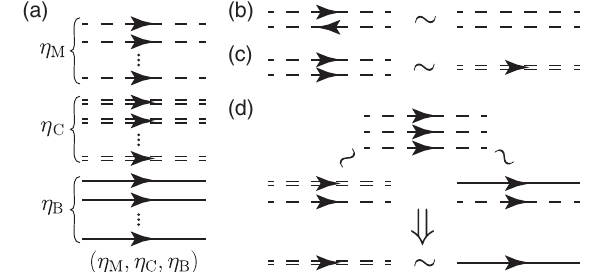
FIG. 9. Equivalence of fermionic and bosonic chiral edges. (a) For a system with Majorana fermions (dashed lines), complex fermions (double dashed lines) and hard-core bosons (solid lines), a chiral edge can be labeled by the tuple of integers ð η M ; η C ; η B Þ , where j η j counts the net number of chiral edges for the three particle types, and its sign encodes the chirality. (b) Two counterpropagating Majorana chiral edges will annihilate, cor- responding to ð 1 ; 0 ; 0 Þ þ ð − 1 ; 0 ; 0 Þ ∼ ð 0 ; 0 ; 0 Þ . (c) Two copropa- gating Majorana edges are equivalent to one complex fermionic edge, implying ð 2 ; 0 ; 0 Þ ∼ ð 0 ; 1 ; 0 Þ . (d) Using a relabeling argu- ment, one sees that ð 3 ; 0 ; 0 Þ ∼ ð 1 ; 0 ; 1 Þ , and therefore ð 0 ; 1 ; 0 Þ ∼ ð 0 ; 0 ; 1 Þ ; i.e., a chiral complex-fermion edge is equiv- alent to a chiral hard-core-boson